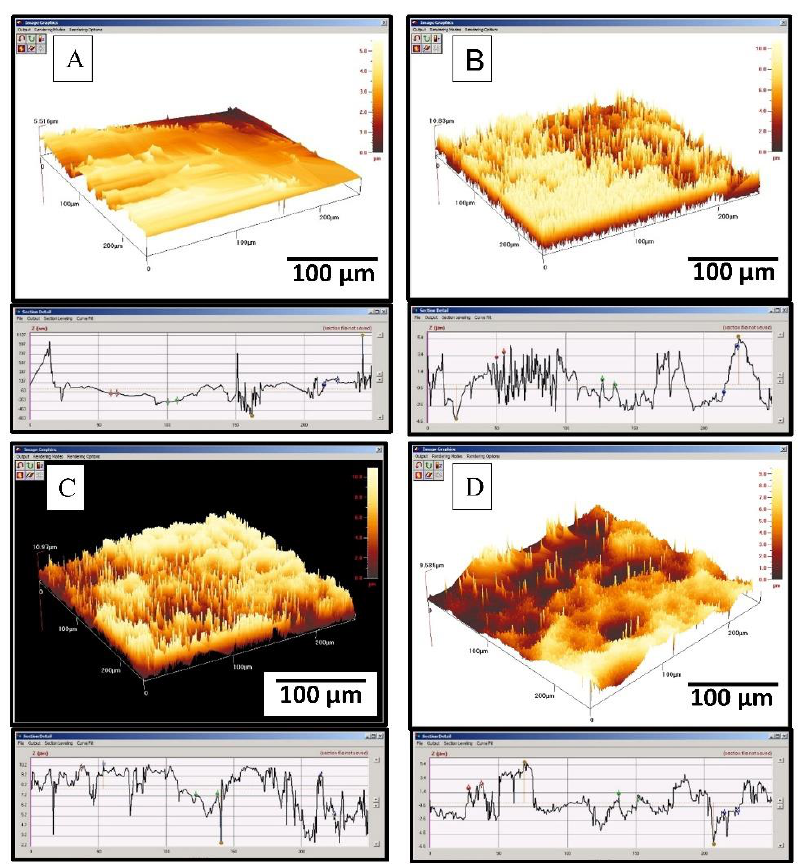
Figure 8. Ra value measurement: ( A ) machined, ( B ) sand blasted, ( C ) sand blasted and acid-etchedat RT (10 min), and ( D ) sand blasted and acid-etched at HT (5 min.). Table 2. Ra Value of the different experimental surfaces of the dental implant.